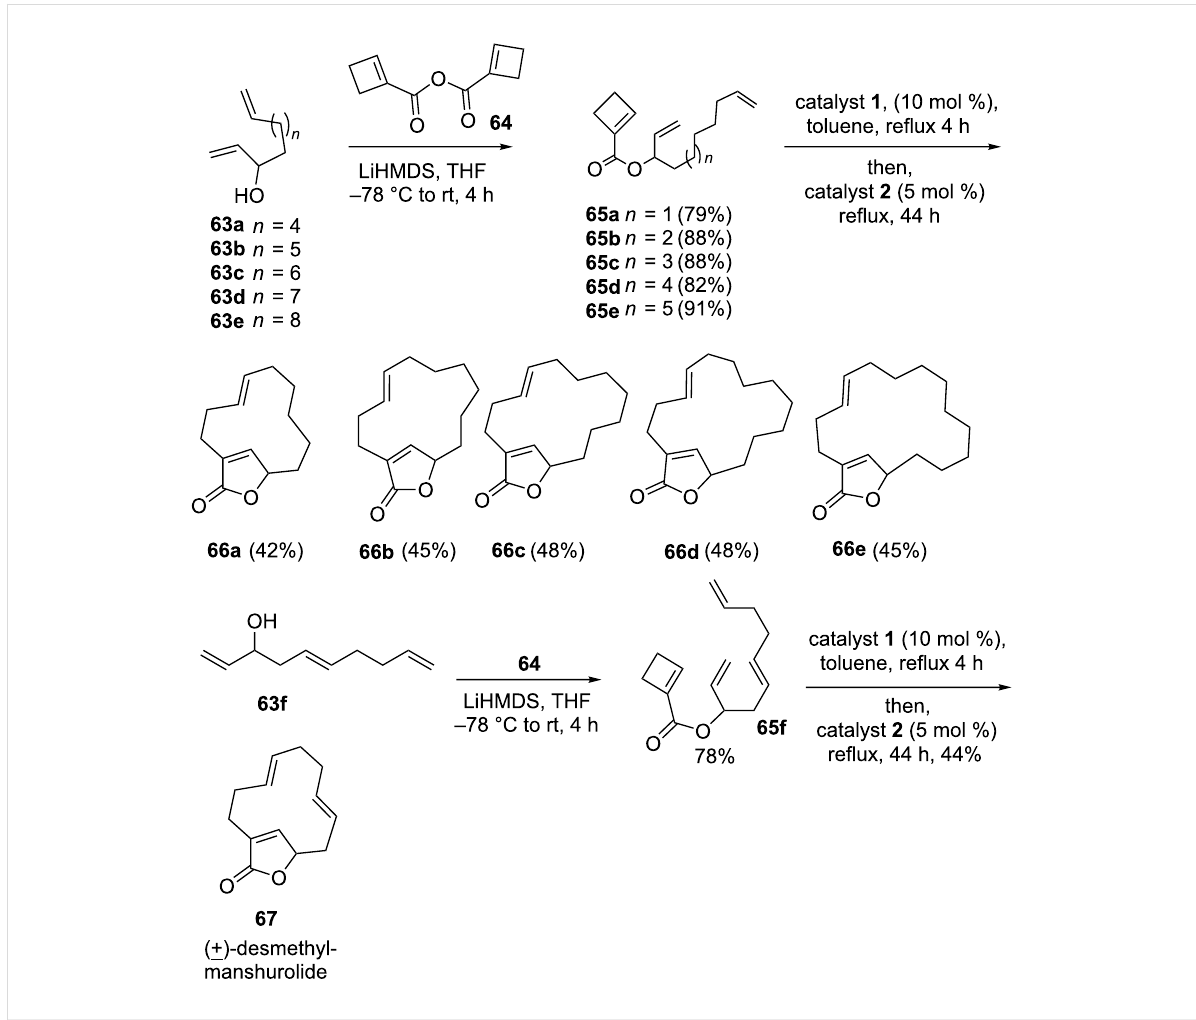
Scheme 11: RRM strategy towards the synthesis of various macrolide rings.